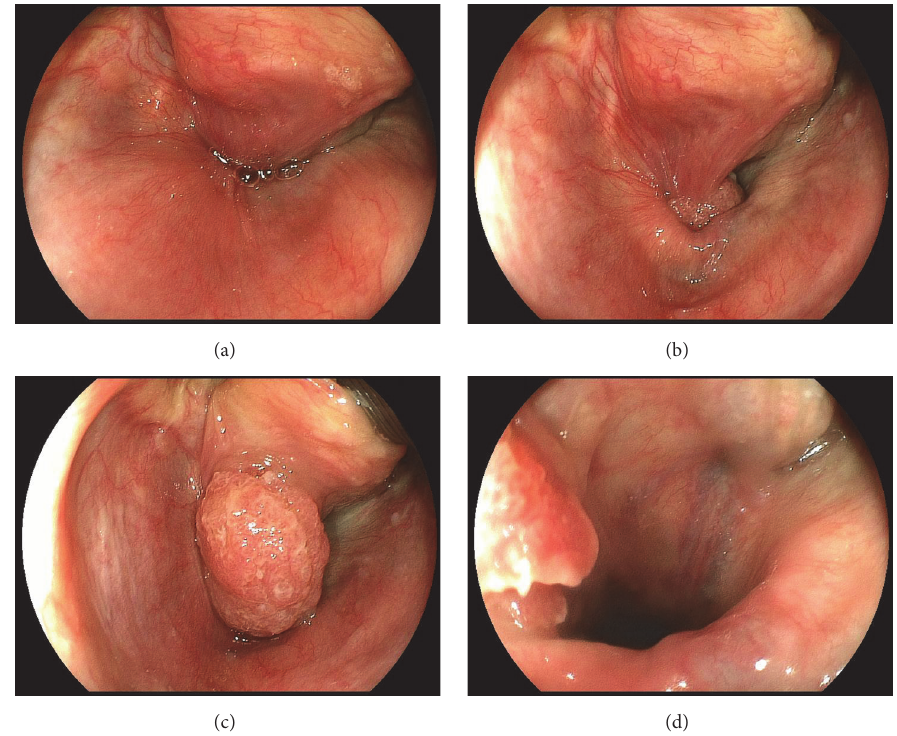
Figure 2: (a) The curved laryngoscope enabled a view of the whole hypopharynx, including the apex of the piriform sinus and the orifice of the esophagus. The tumor was invisible from the hypopharynx. (b) The tumor was pulled up from the cervical esophagus to the hypopharynx. (c) The pedicle of the tumor was mainly located at the postcricoid area. (d) The flat, superficial part and the anal side of the tumor had spread to the cervical esophagus.